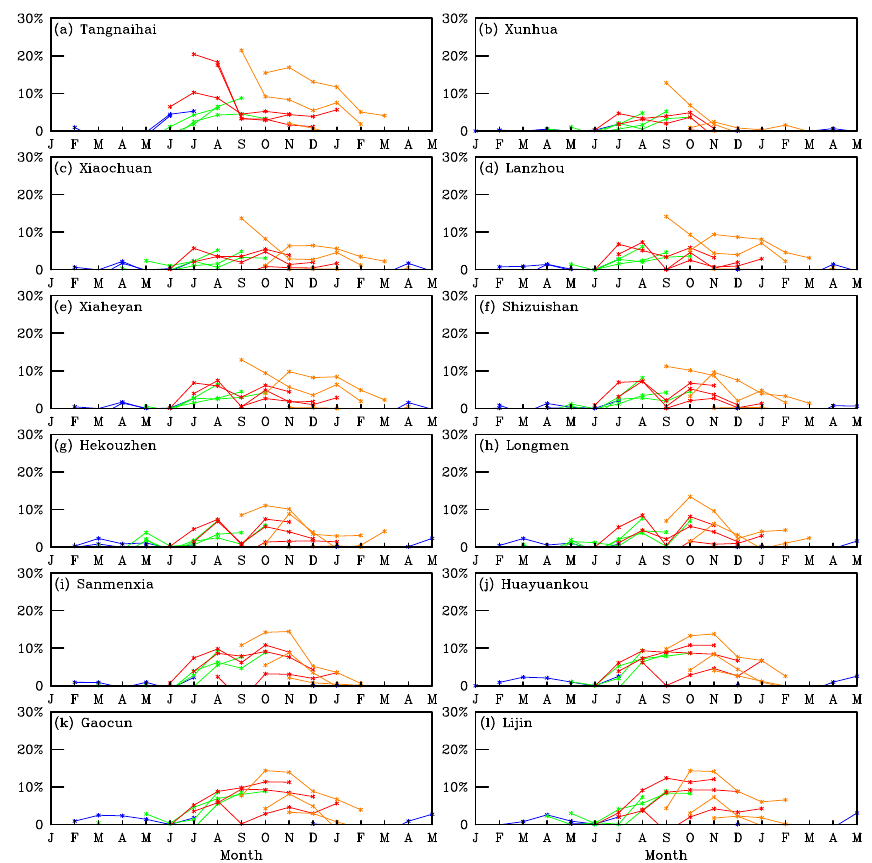
Figure 9. The same as Fig. 8, but the RMSEs are calculated against observed